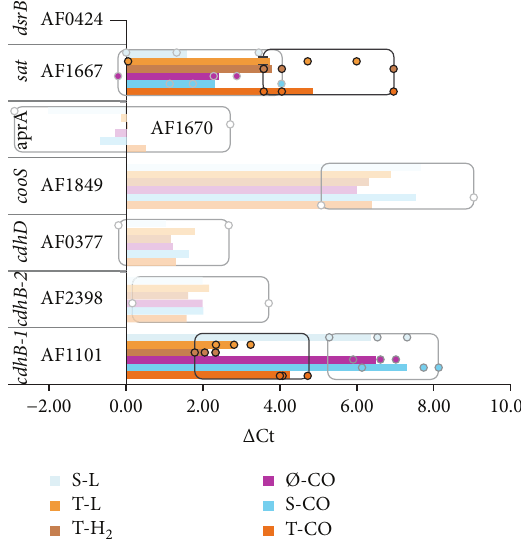
Figure 2: Overview of shift ( Δ Ct) in real time PCR cycle threshold (Ct) values between control ( dsrB /AF0424) and subsequent assayed transcripts. Average Δ Ct values are indicated by bars. The data range for nonsignificant shifts in gene expression is transparent and the data range (min-max) is indicated by boxes. A significant shift(ANOVA)wasfoundbetweenthiosulfategrowncultures(black squares) and cultures with sulfate, or no electron acceptor (gray squares) for AF1101 ( ΔΔ Ct − 2.22, 𝑝 4.7 × 10 −7 ) and AF1667 ( ΔΔ Ct 1.97, 0.04). Low expression levels (i.e., high Δ Ct values) indicate lower levels for transcripts of cooS during all conditions and cdhB-1 during growth with sulfate or no electron